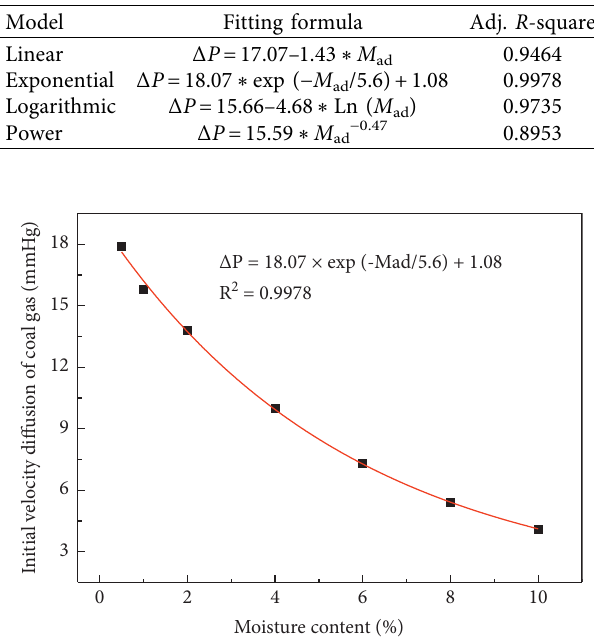
Table 2: Te regression analysis results.